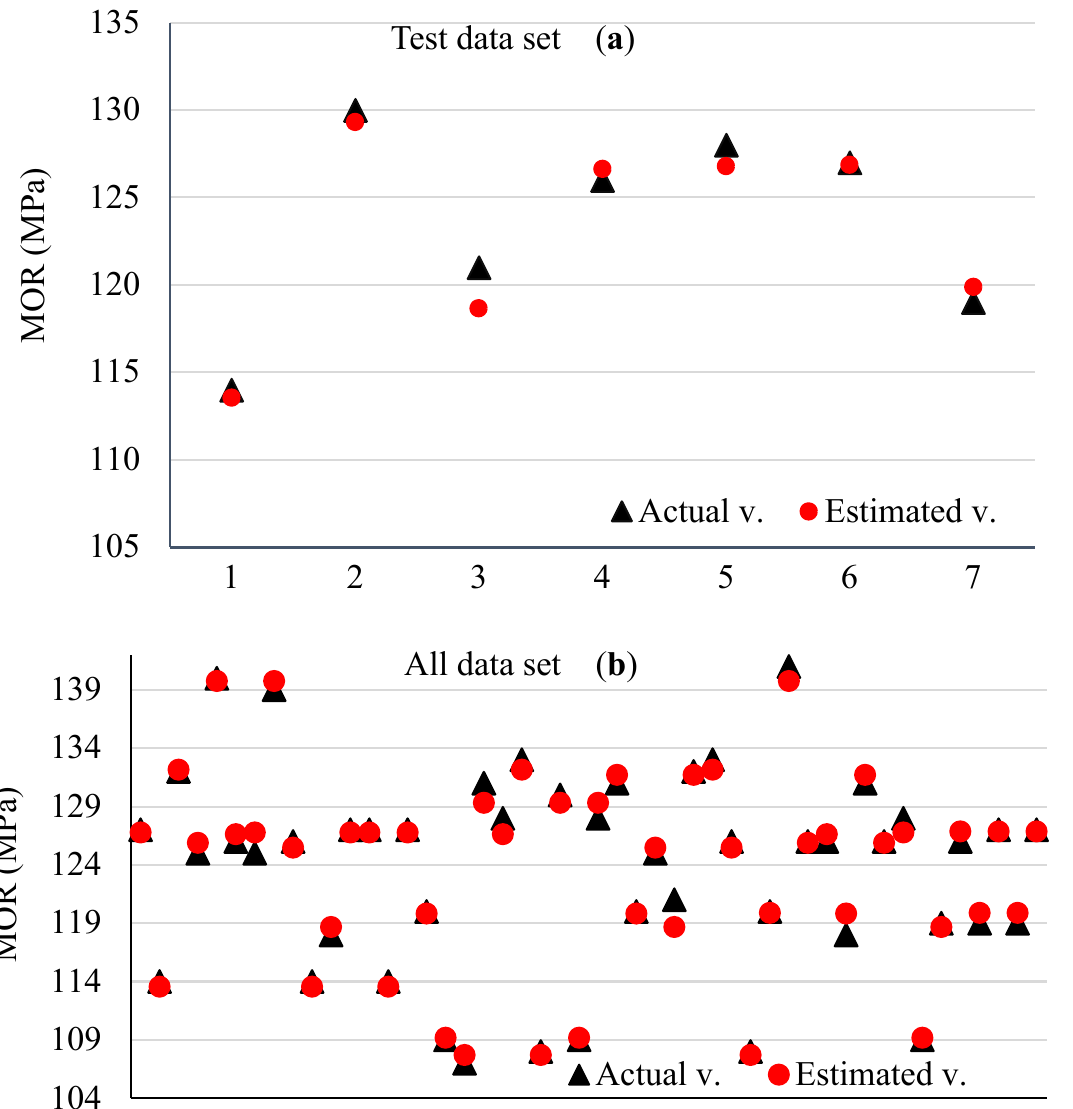
Figure 5. The comparison of the real and predicted values of the test ( a ) and all data ( b ) sets.